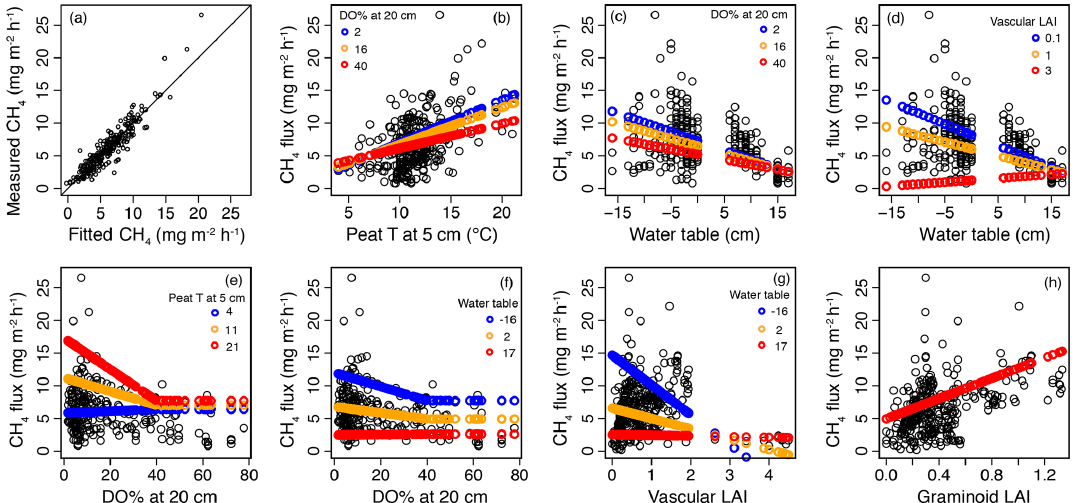
Figure 6. Results of the mixed-effect model, which was constructed to provide a robust mechanistic understanding of the controls of methane (CH 4 ) flux in the valley fen using the 2019 dataset. (a) Measured CH 4 flux values plotted against fitted values of the mixed-effect model. (b– h) Response curves of CH 4 flux to (b) peat temperature ( T ) at 5cm below the surface, (c, d) water table, (e, f) dissolved oxygen concentration (DO%) at 20cm below the surface, (g) vascular plant leaf area index (LAI), and (h) graminoid plant LAI with the interactive variable adjusted at three different levels (rounded minimum, average, and maximum values of the observed dataset; indicated by three different colours) and the other variables kept constant. When setting variables as constant, the median values of the dataset were chosen, i.e. 11 ◦ C for peat T at 5cm, − 11 (response to DO% at 20cm) and − 1cm (other responses) for water table, 7 for DO% at 20cm (when < 40%), 0.6 for vascular LAI, and 0.3 for graminoid